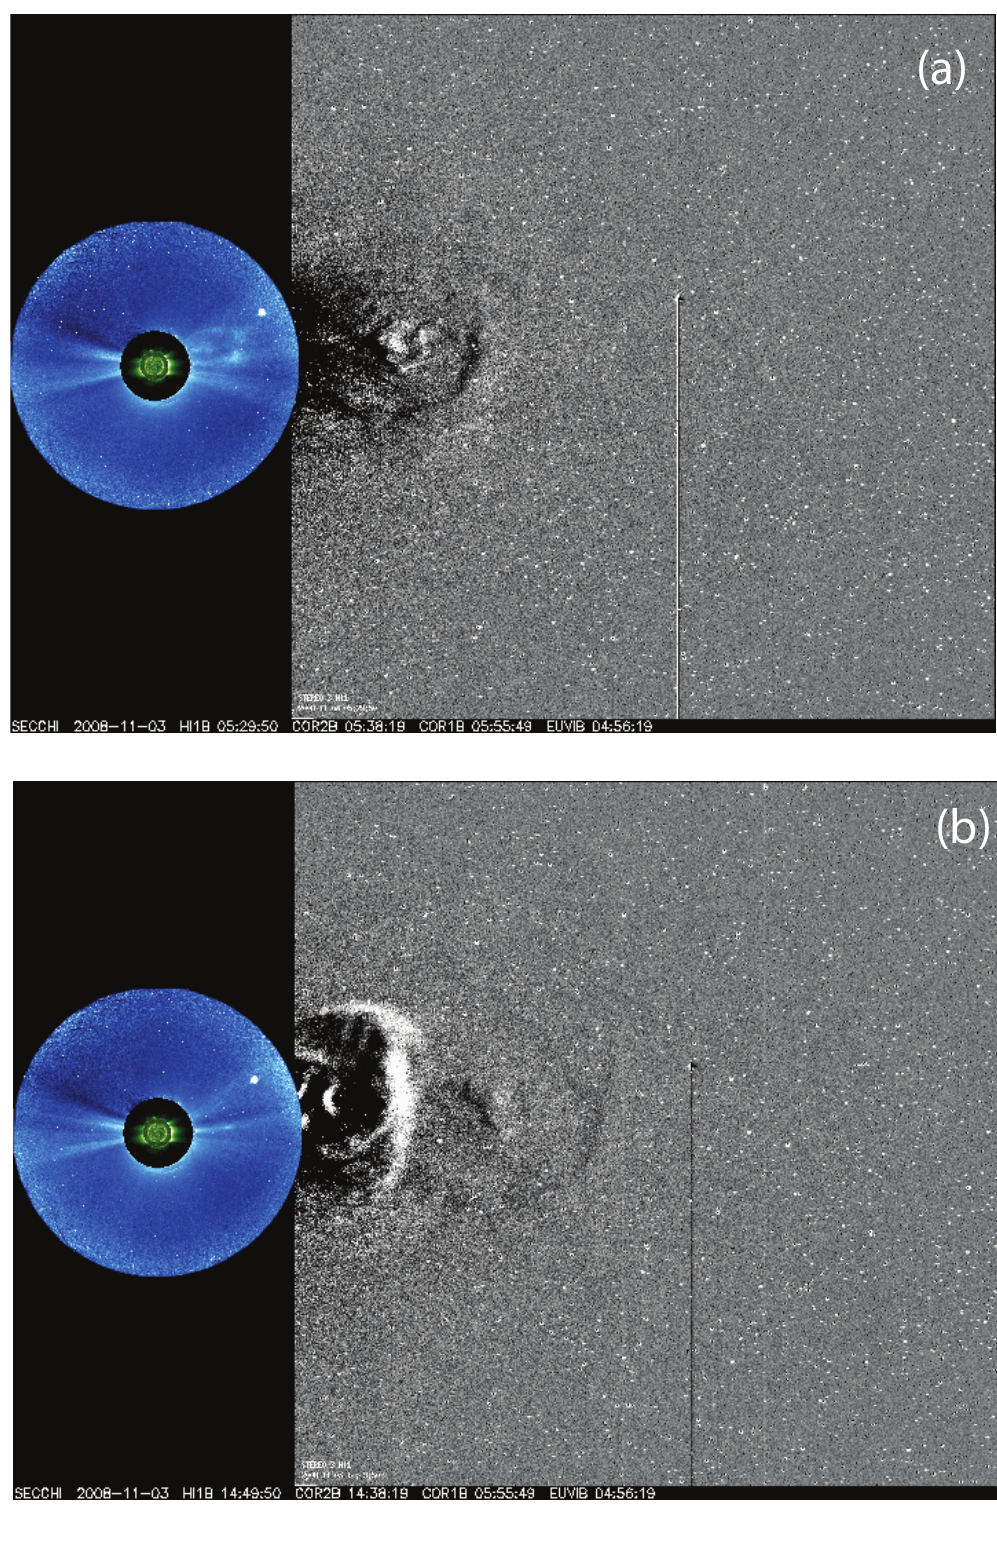
Fig. 4. Snapshot images by STB/SECCHI COR2 and HI-1 instruments featuring (a) CME1 in COR2 on 3 November 2008 05:38:19UT and in HI-1 on 3 November 2008 at 05:29:50UT and (b) both CMEs in HI-1 on 3 November 2008 at